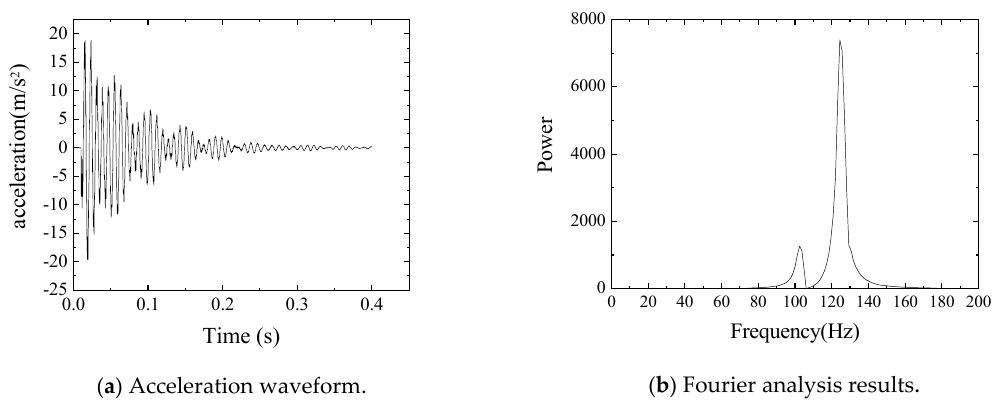
Figure 8. Accelerometer installation position (unit: mm).